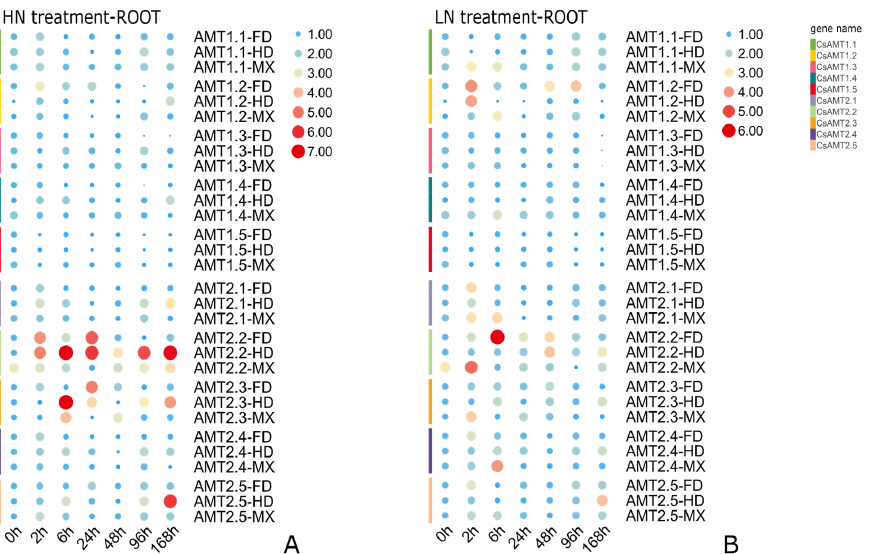
Figure 6. The expression diversity of each CsAMT gene in roots among three different tea plant cultivars. ( A ) Expression differences of each CsAMT2 among three cultivars under high nitrogen (HN, 9.0 mmol NH 4+ ) treatment; ( B ) Expression differences of each CsAMT2 among three cultivars under low nitrogen (LN, 0.8 mmol NH 4+ ) treatment. The expression level of each gene at 0 h in FD’s roots was used as the control. The average values of three biological replicates and three technological replicates were used to generate a heat map using TBtools software. The color scale represents the normalized value converted by log2. Red indicates a relatively high expression level, blue indicates a relatively low expression level, and the circle size represents the expression levels.